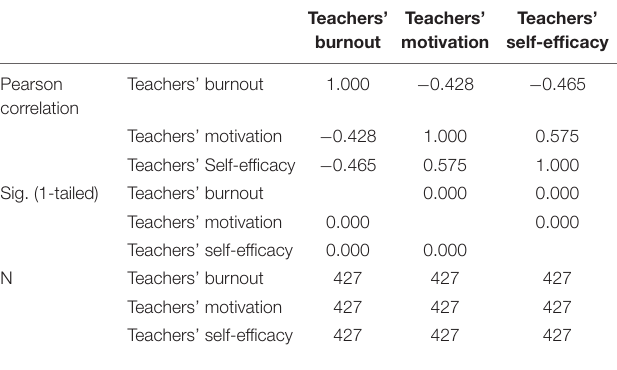
TABLE 4 | Correlations table of the